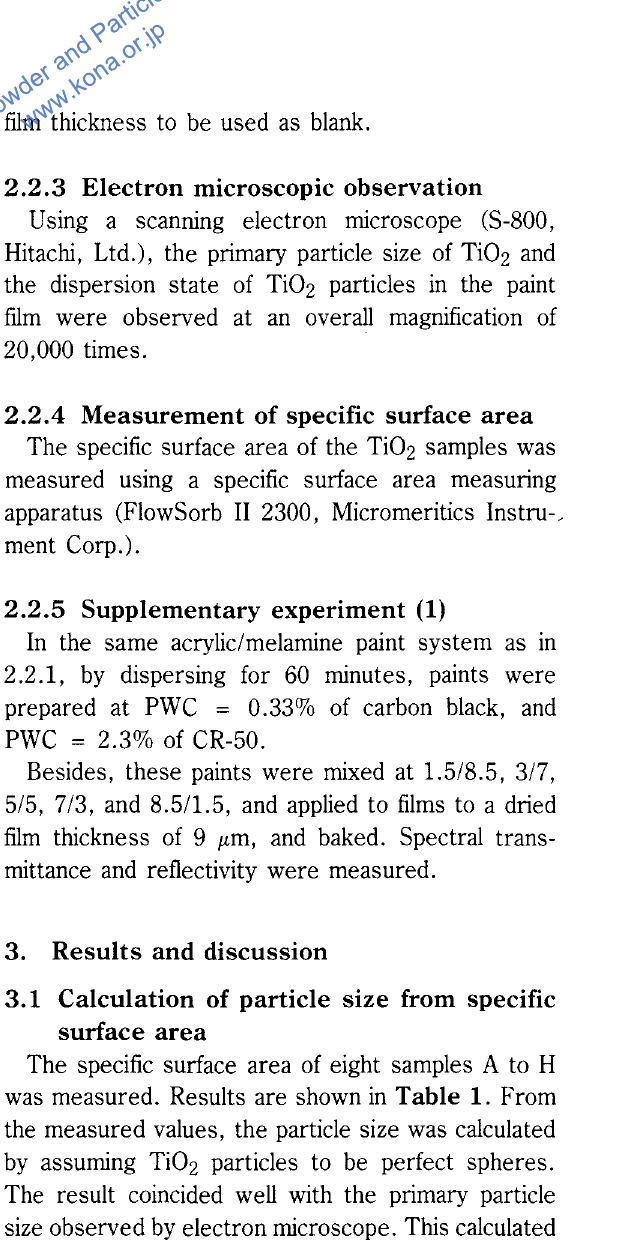
Table-1 Primary particle size (estimated from S.S.A. *value)